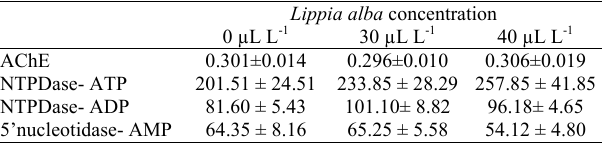
Table 1. Enzymatic activity in the brain. The levels of AChE expressed as µmol ASCh hydrolyzed min -1 mg protein -1 and the levels of NTPDase and 5’-nucleotidase activity using either ATP or ADP and AMP as substrates, respectively (values expressed as nmol Pi min -1 mg protein -1 ).